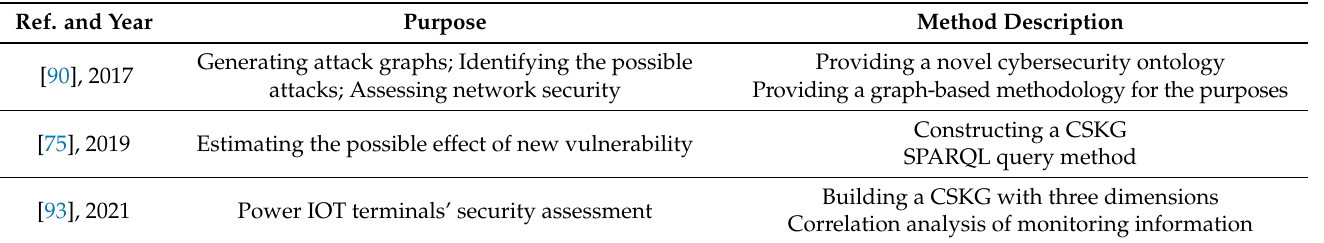
Table 3. The knowledge graph’s application in security assessment